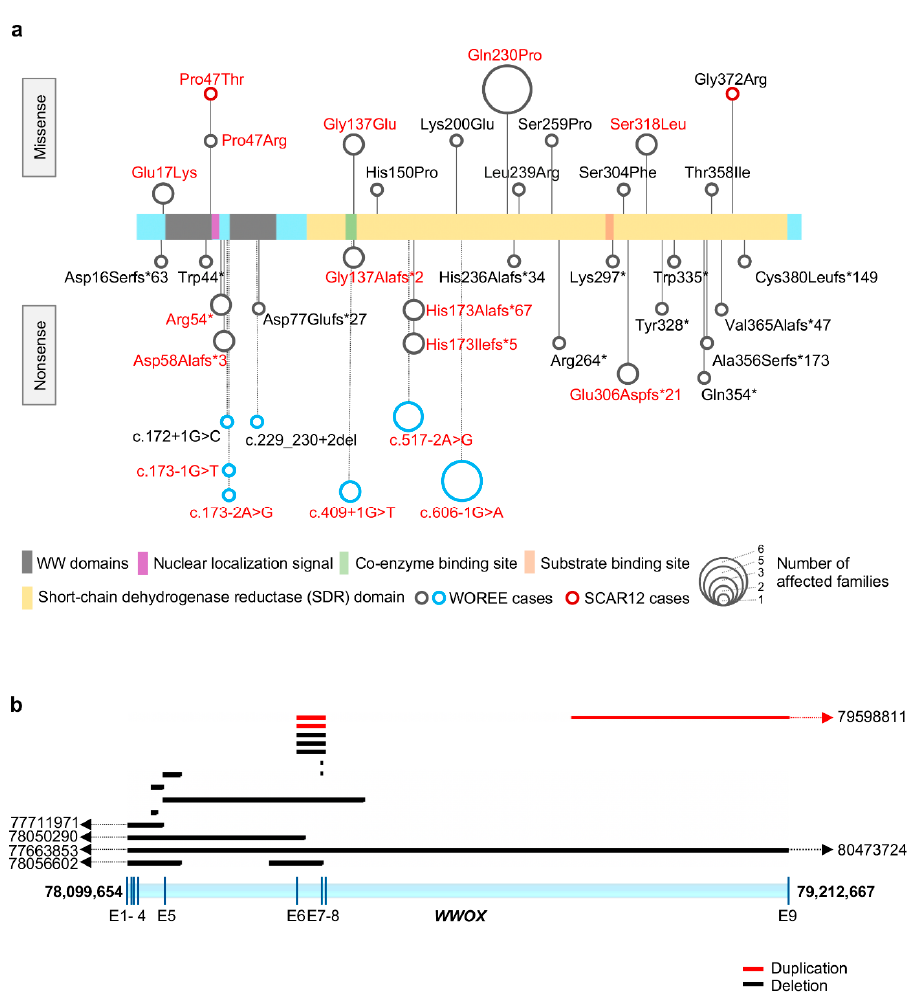
Figure 7. WWOX germline pathogenic variants in SCAR12 and WWOX -related epileptic encephalopathy (WOREE). ( a ) Missense, nonsense, and splice-site/intronic variants affecting WWOX protein in SCAR12 (red colored circles) and WOREE cases (gray colored circles for amino acid alterations and blue colored circles for splice-site/intronic variants). Size of each circle corresponds to the frequency of occurrence of the specific variant in single or multiple families, as noted. Mutation hotspots with more than one mutation at the same amino acid site or variants identified in more than one family are noted in red text. ( b ) Mapping of germline CNVs, duplications shown in red and deletions in black, of the WWOX locus in WOREE cases. Numbers next to dotted lines with arrowhead indicate coordinates of chromosomal breakpoints beyond the WWOX locus (human genome assembly GRCh38 /